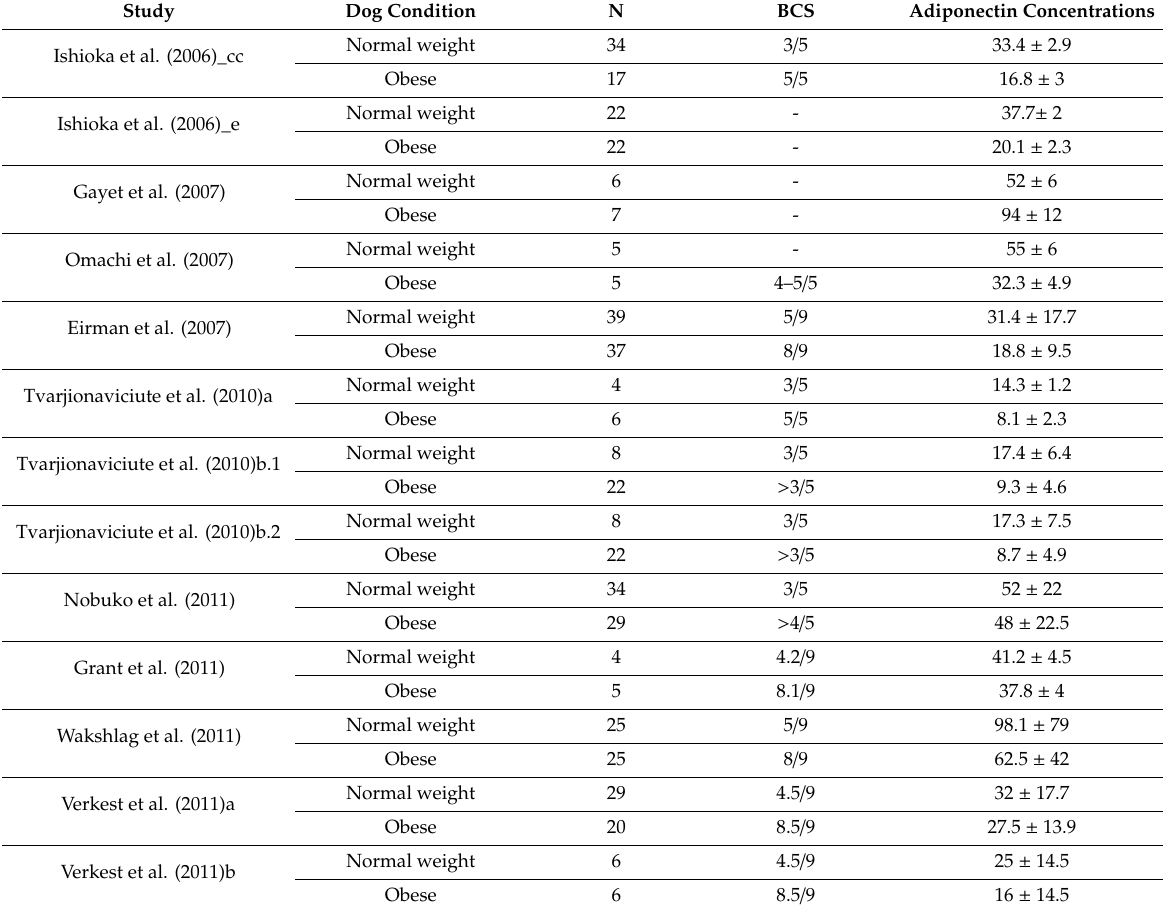
Table 3. Body condition score and adiponectin concentrations of individual studies included in the